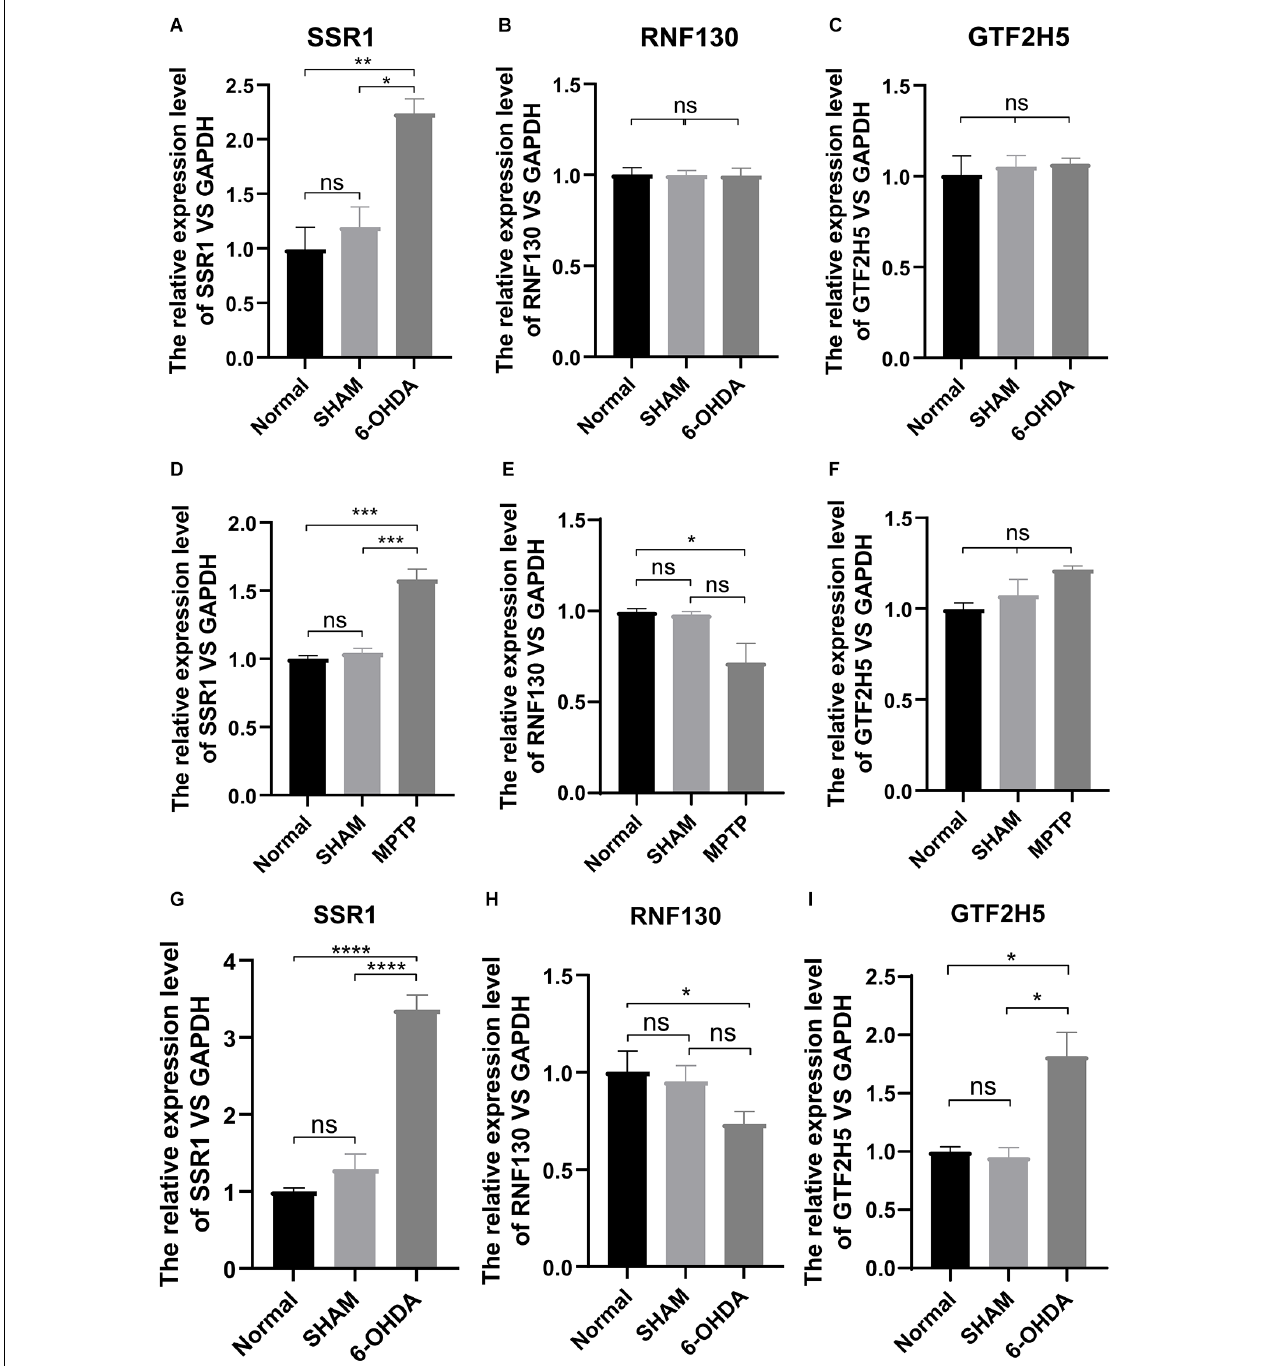
FIGURE 6 | The mRNA relative expression levels of SSR1, GTF2H5, and RNF130 in PD model mice. (A–C) The expression levels of SSR1, GTF2H5, and RNF130 in SN (substantia nigra) in vivo in PD animal model constructed with 6-OHDA. (D–F) The expression levels of SSR1, GTF2H5, and RNF130 in SN (substantia nigra) in vivo in PD animal model constructed with MPTP. (G–I) The expression levels of SSR1, GTF2H5, and RNF130 in whole blood in vivo in PD animal model constructed with 6-OHDA. Norrnal group (non injected mice), SHAM group (PBS injected mice); ns p > 0.05, * p < 0.05, ** P < 0.01, *** P < 0.001, **** P < 0.0001 vs. each